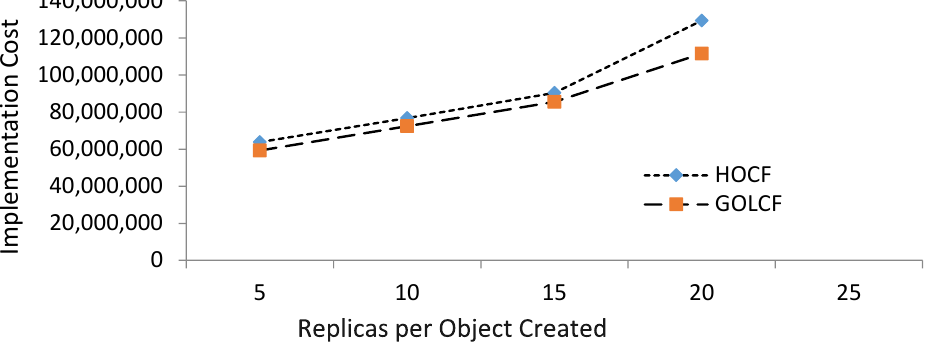
Figure 4. Cost of replica transfer scheduling problem (RTS)-based algorithms.